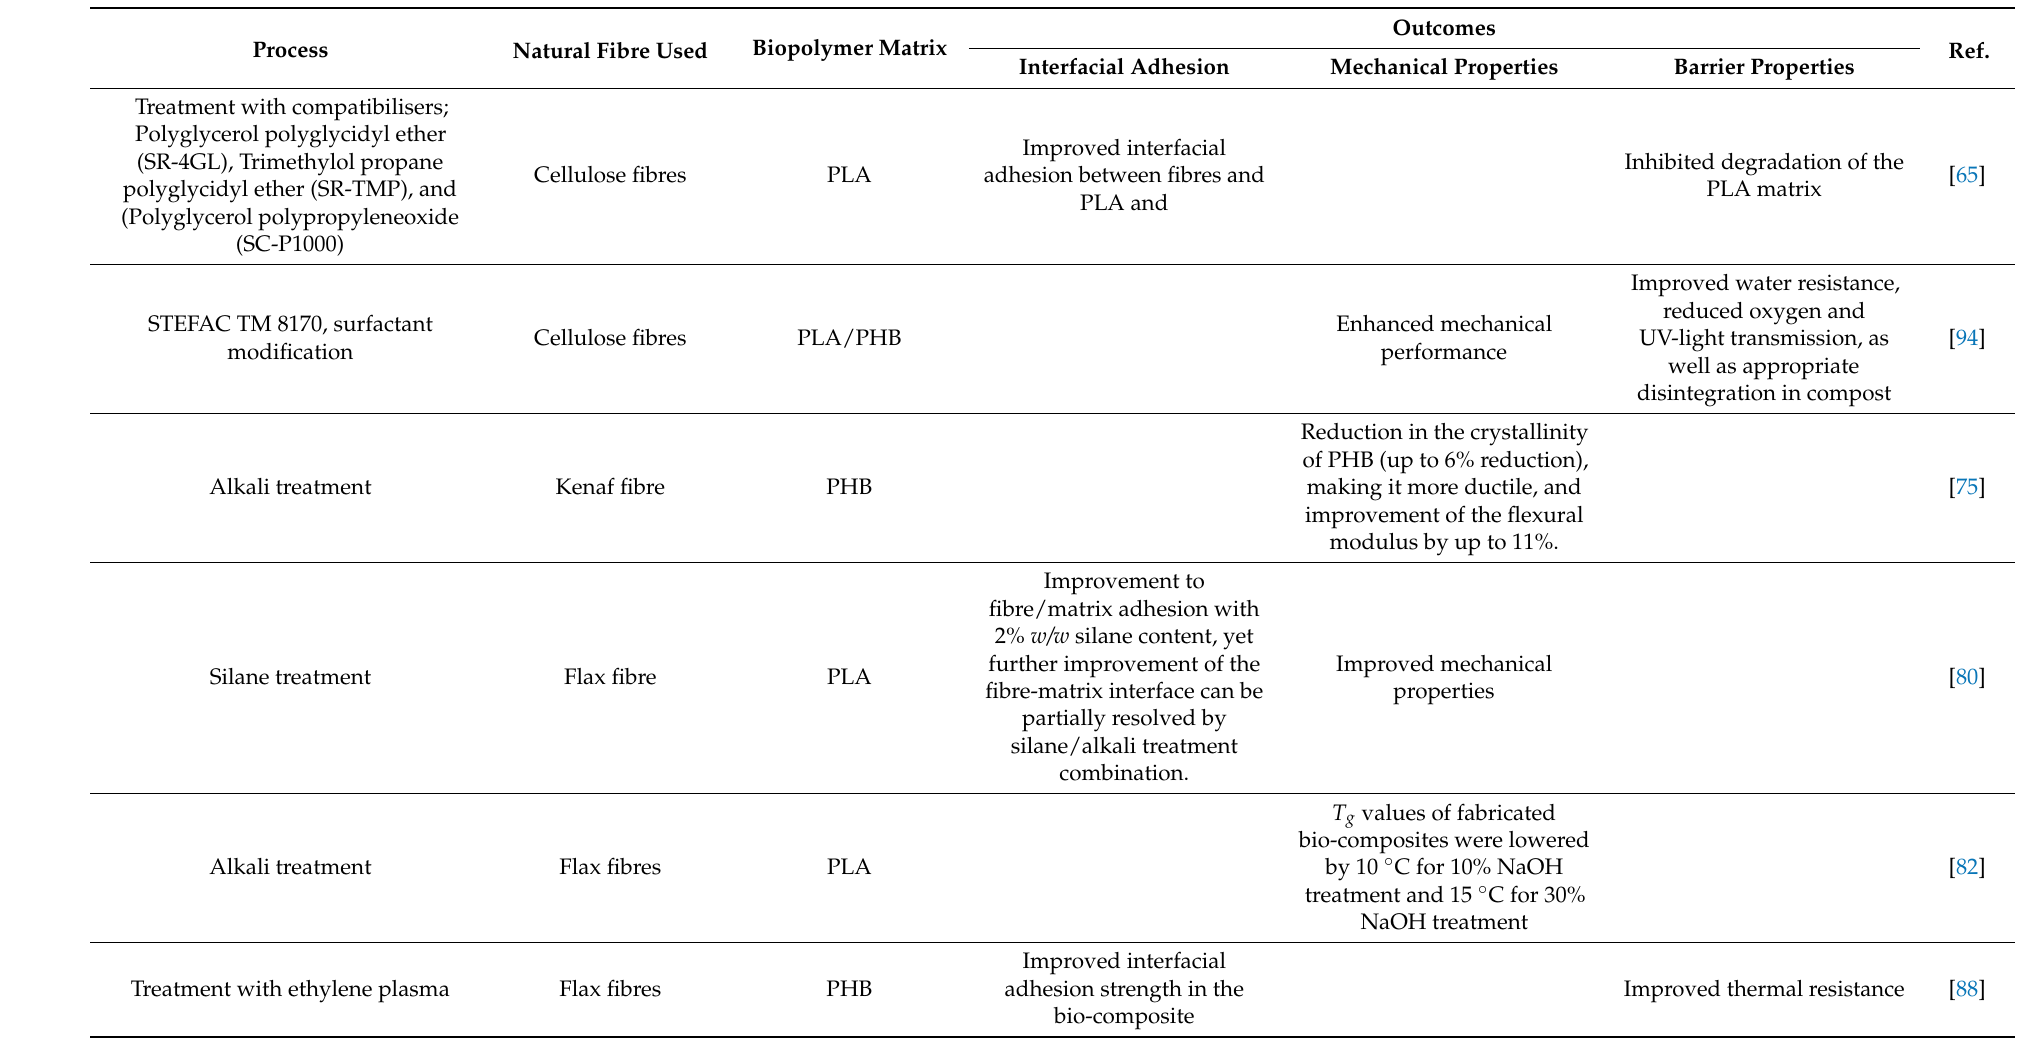
Table 3. Surface treatment of natural fibres reinforced